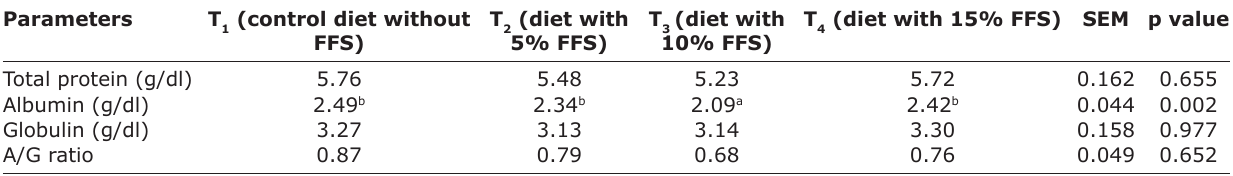
Table-4: Effect of dietary supplementation of FFS on serum protein profile (g/dl) of broiler Japanese quails at 5 weeks of age. Parameters